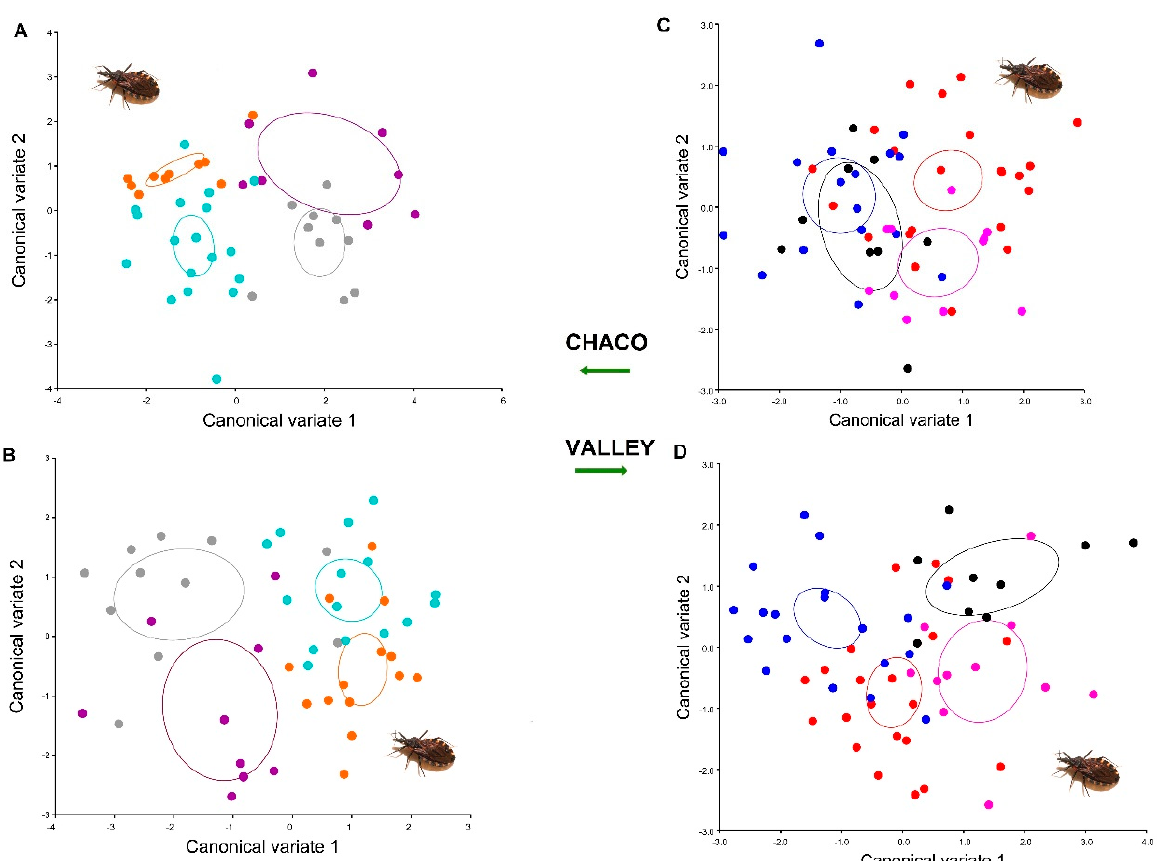
Figure 6. Scatterplot of the canonical variate analysis of Triatoma infestans populations of Chaco and Inter-Andean valley ( A ) Canonical variate analysis (CVA) of head dorsal view Huacaya/Imbochi and Monteagudo/Cañon Largo; ( B ) CVA of wing view Huacaya/Imbochi and Monteagudo/Cañon Largo; ( C ) CVA of head dorsal view Tarabuco/Sarufaya and Sucre/Surima; ( D ) CVA of wing view Tarabuco/Sarufaya and Sucre/Surima. Orange: female/Huacaya-Imbochi; light blue: male/Huacaya-Imbochi; gray: female/Monteagudo-Cañón Largo; purple: male/Monteagudo Cañón Largo; red: female/Sucre-Surima: blue; male/Sucre-Surima; pink: female/Tarabuco-Sarufaya; black: male/ Tarabuco Sarufaya. Table 1. Pairwise comparison using Mahalanobis distance and Procrustes distance between females and males of Triatoma infestans inter-Andean Valley and Chaco population (* p < 0.0001). Mahalanobis Distance Procrustes Distance View Region F/Chaco F/Valley M/Chaco F/Chaco F/Valley Head dorsal